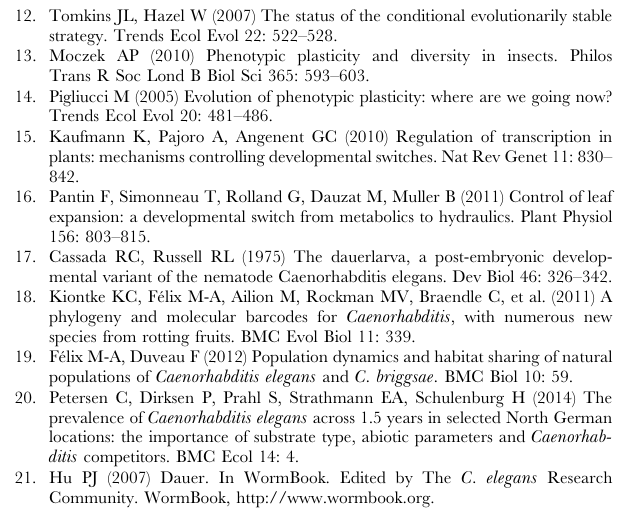
Table S1 Comparisons of dauer larvae formation in response to defined amounts of pheromone between introgression lines and N2. Shown are the numbers of dauer larvae, the number of non-dauer larvae (L4s), the total number of worms, and the x 2 value from a comparison with dauer larvae formation in the N2 controls. Significant comparisons are noted and ‘effect of CB allele’ indicates if the CB4856 genotype at the QTL increases (P) or decreases (N) the number of dauer larvae in comparison to N2. The QTL ‘limits’ columns denote the maximum possible QTL regions defined by these comparisons. Table S2 Comparisons of dauer larvae formation in response to defined amounts of pheromone between introgression lines with overlapping regions of the CB4856 genome. Shown are the ILs tested, the numbers of dauer larvae, the number of non-dauer larvae (L4s), the total number of worms, and the x 2 value from a comparison between the ILs. Significant comparisons are noted and ‘effect of CB allele’ indicates if the CB4856 genotype at the QTL increases (P) or decreases (N) the number of dauer larvae in comparison to N2. The QTL ‘limits’ columns denote the maximum possible QTL regions defined by these comparisons. Table S3 Locations and effect of QTLs detected for dauer larvae formation in response to defined amounts of pheromone. ‘Line’ indicates the IL or the IL by IL test in which the QTL is detected, ‘effect’ indicates if the CB4856 genotype at the QTL increases (P) or decreases (N) the number of dauer larvae in comparison to N2. The ‘limits’ columns denote the possible QTL regions defined by these comparisons. ‘Overlap’ indicates QTLs that colocalize with QTLs affecting dauer larvae development in growing populations.